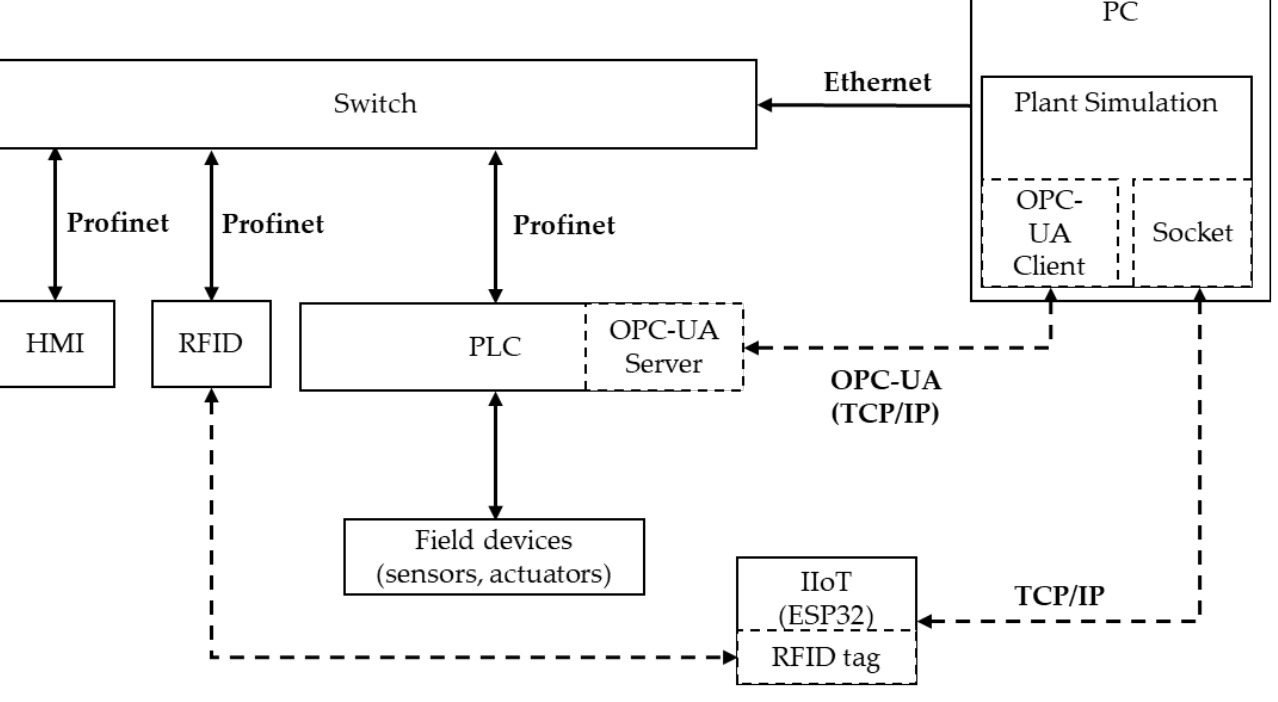
Figure 3. The architecture of the testbed.